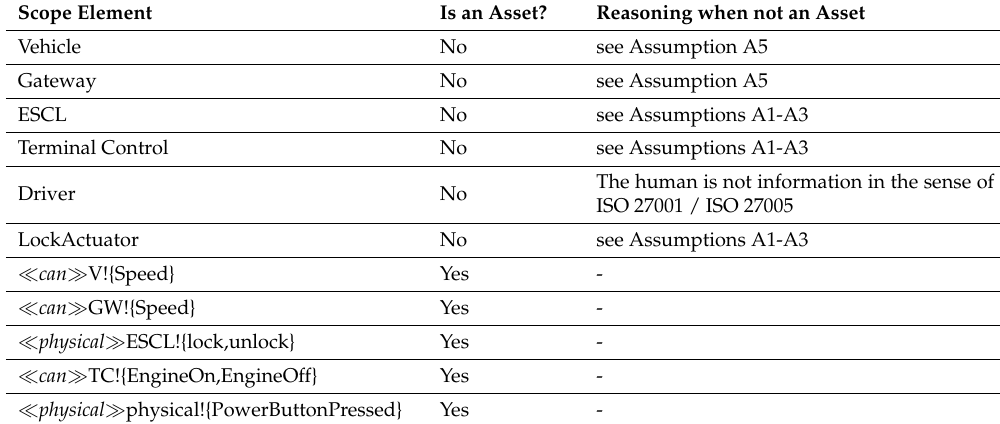
Table 6. Asset Overview